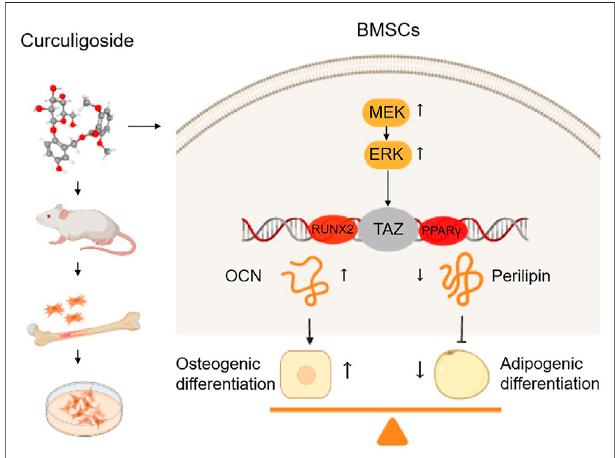
FIGURE 7 | Curculigoside ameliorates bone loss by in fl uencing mesenchymalstemcellfateinagingmice.CCGamelioratedage-relatedbone loss by upregulating TAZ expression to induce switch from adipogenesis to osteogenesis of BMSCs in aging mice through MEK/ERK-TAZ axis.